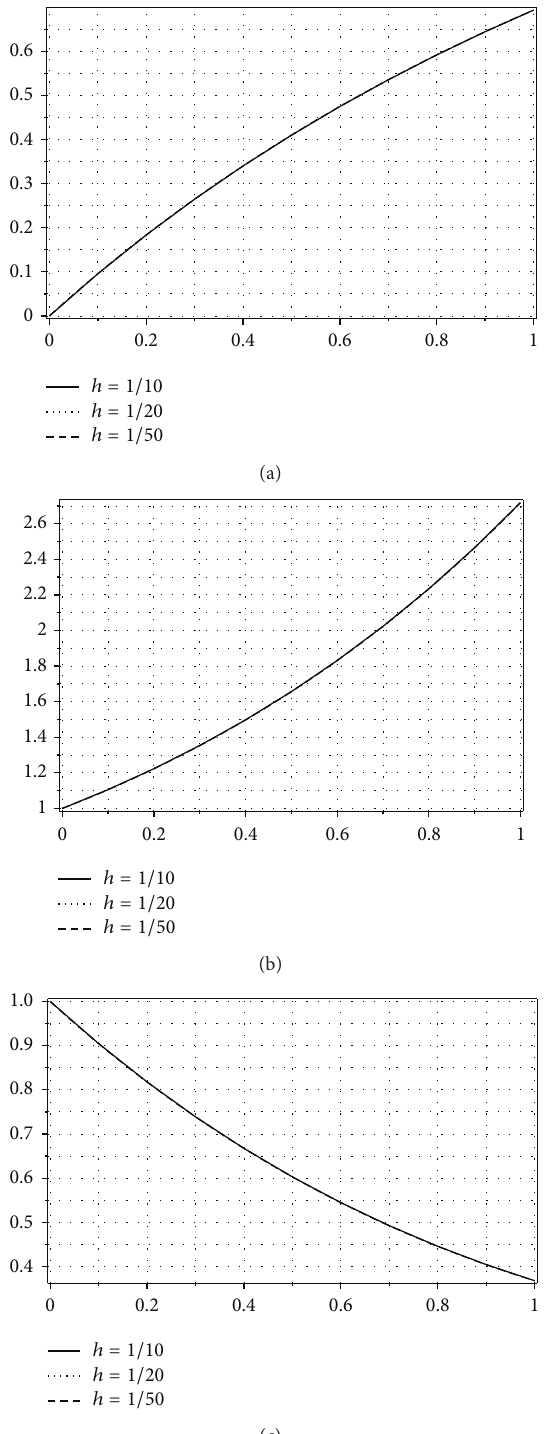
Figure 7: Approximate solutions of Examples 1, 2, and 3 at different step sizes.